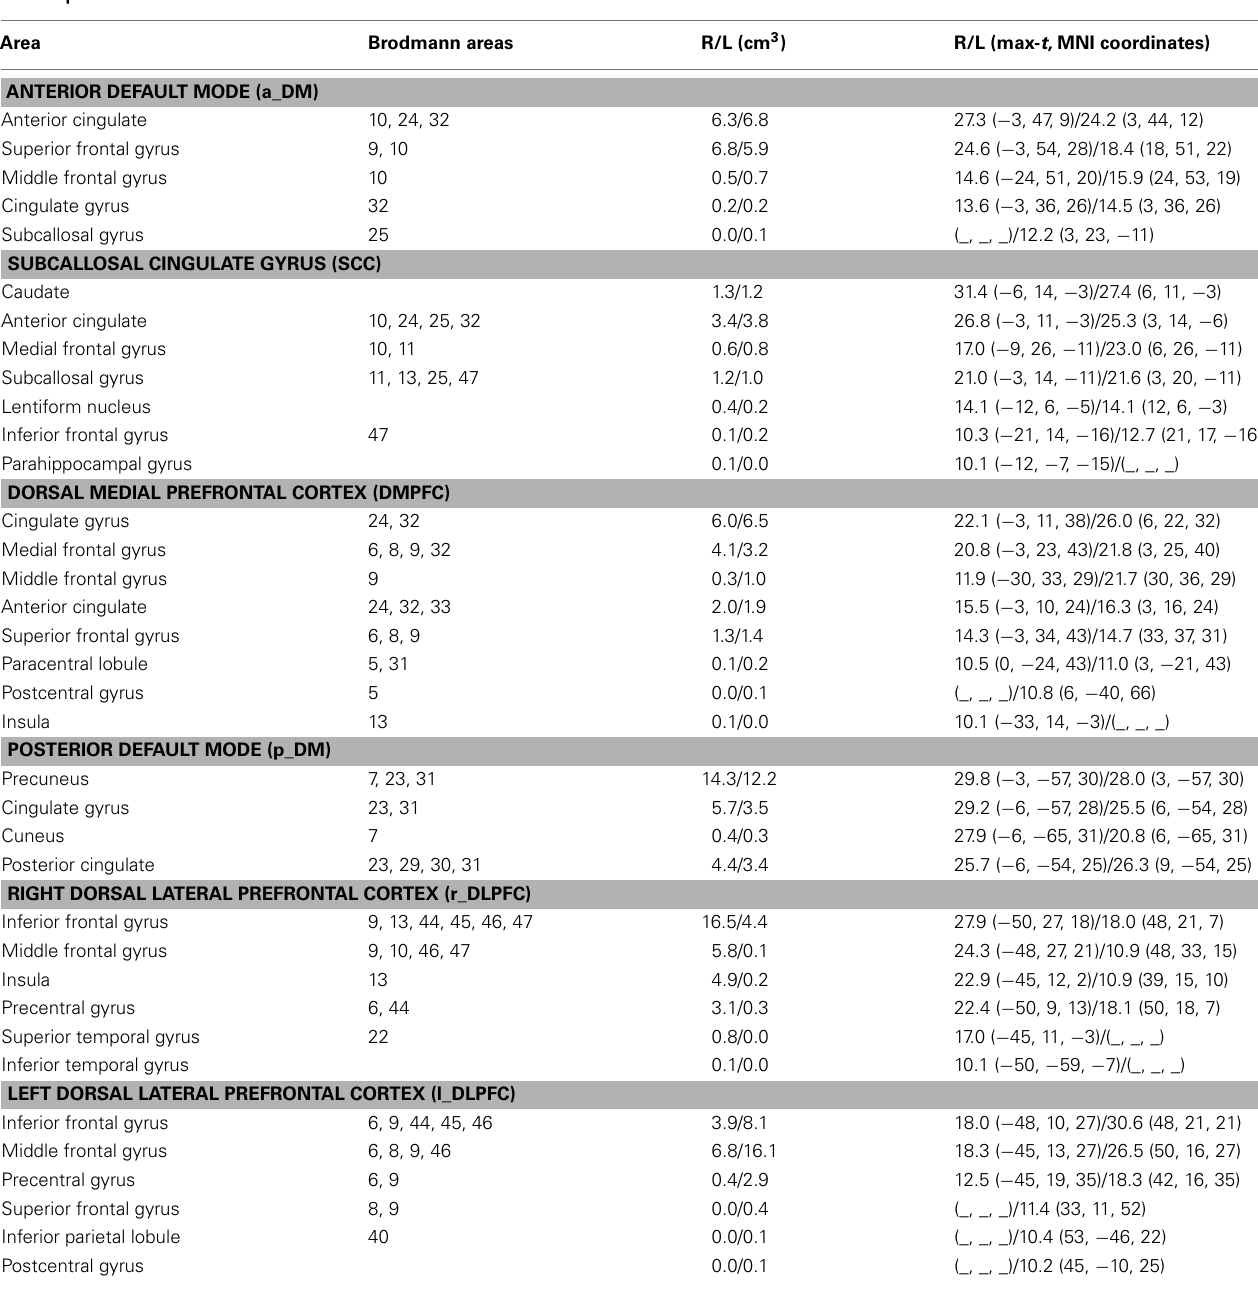
Table 2 | Networks of